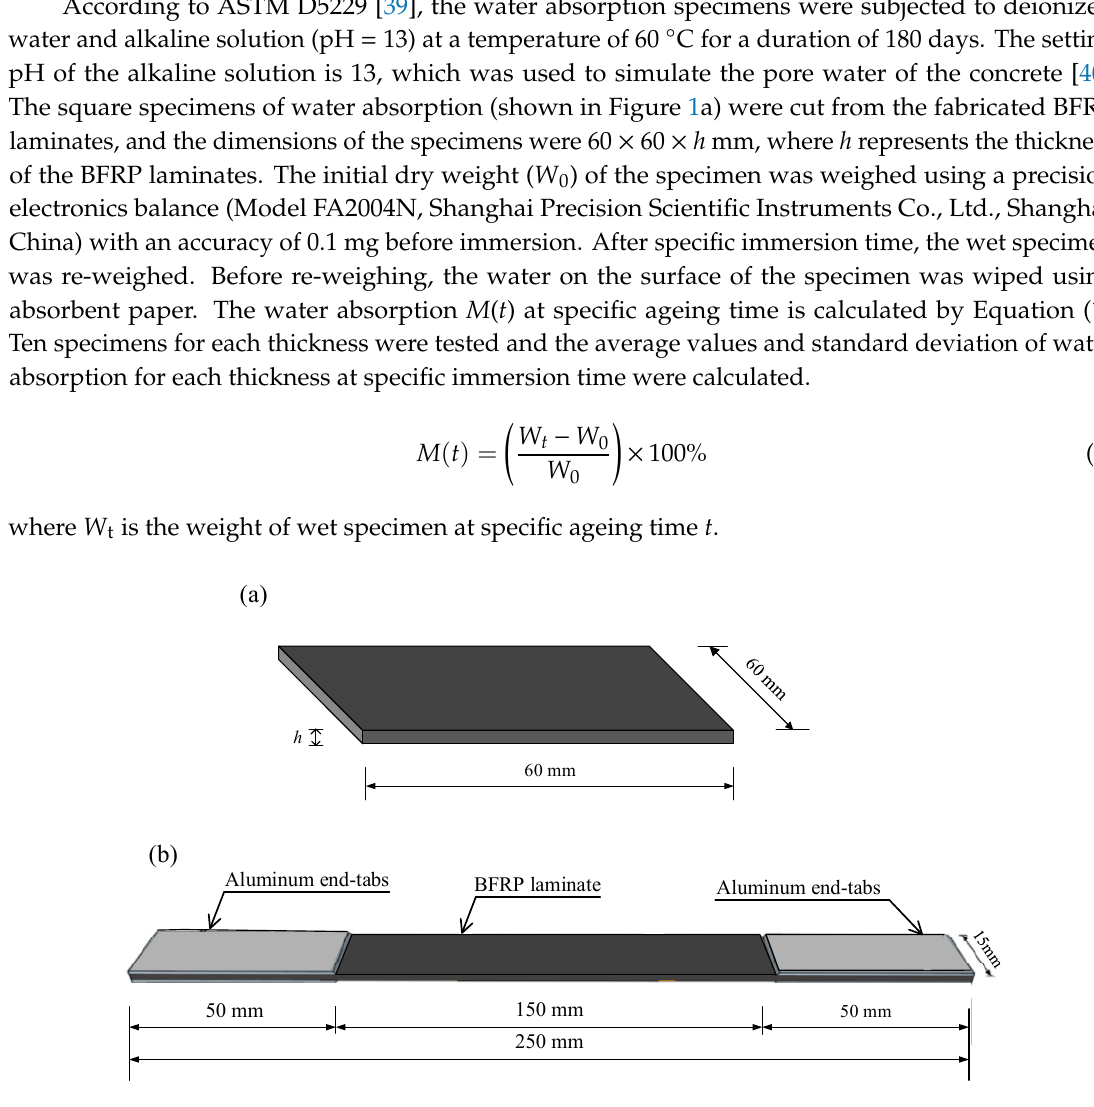
Figure 1. Test specimens of BFRP laminates. ( a ) water absorption test and ( b ) tensile test.